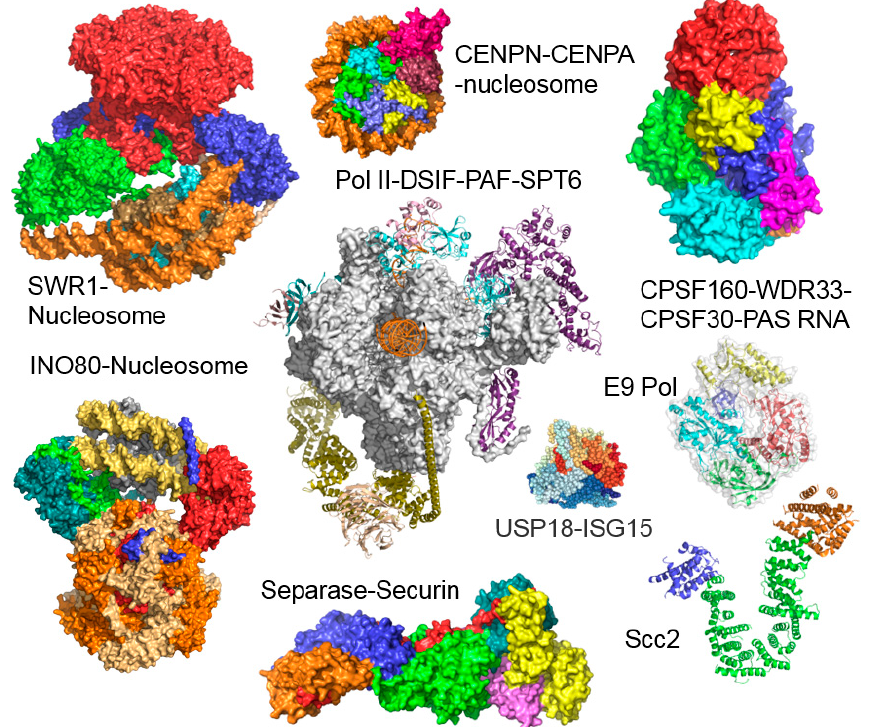
Figure 2. Multiprotein complex structures. Chromatin remodeling enzymes SWR1 (14 subunits) and INO80 (11 subunits) were produced by using MultiBac, bound to nucleosomes and the molecular structures determined by electron cryo-microscopy [37–42]. The yeast polII DSIF-PAF-Spt6 cryo-EM structure utilized RNA polymerase II from native source reconstituted with recombinantly expressed associated proteins [43]. Further recent structures of sample produced with the MultiBac BICS include the CENPN-CENPA-nucleosome complex [44], the human CPSF-160–WDR33–CPSF-30–PAS RNA quaternary complex [45], the E9 polymerase [46], the USP18-ISG15 complex [47], the Separase-Securin complex [48] and the cohesion loader Scc